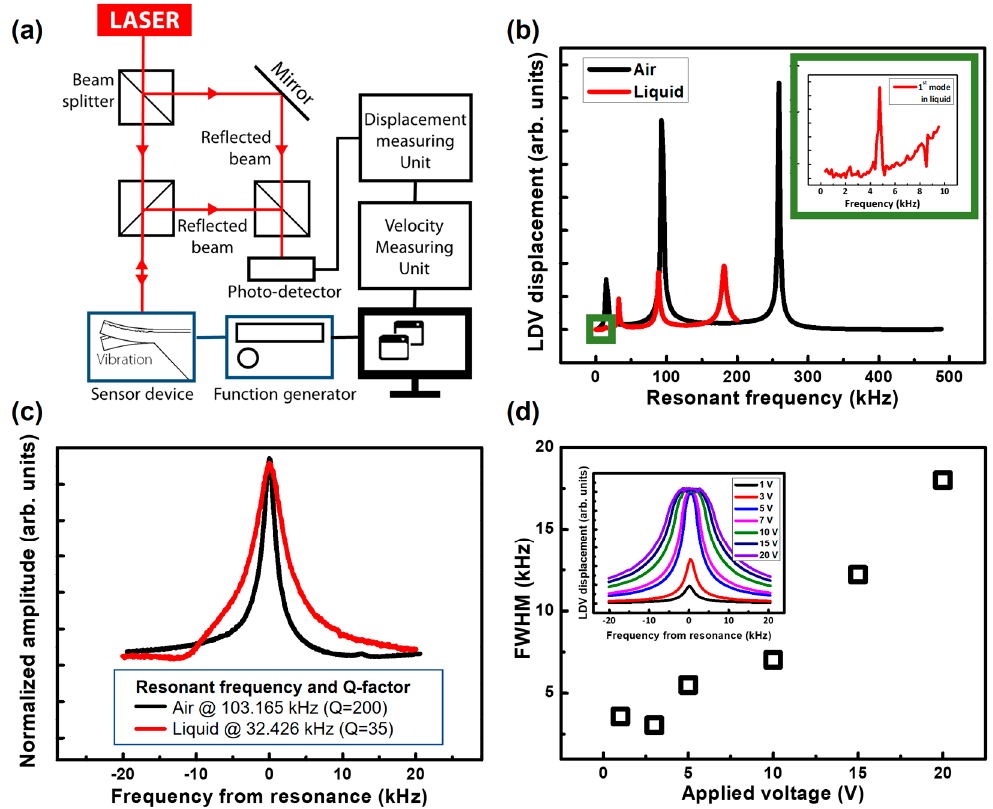
Figure 3. Characterization of resonating slit cantilever in air and liquid conditions. ( a ) An optical measurement setup of the slit cantilever sensor; ( b ) Measurement of first ~ third mode resonant frequencies in air and distilled water; ( c ) Direct comparison of an identical mode resonance peak between air and liquid phases; ( d ) Optimization of an induced voltage toward the PZT self-actuating layer.